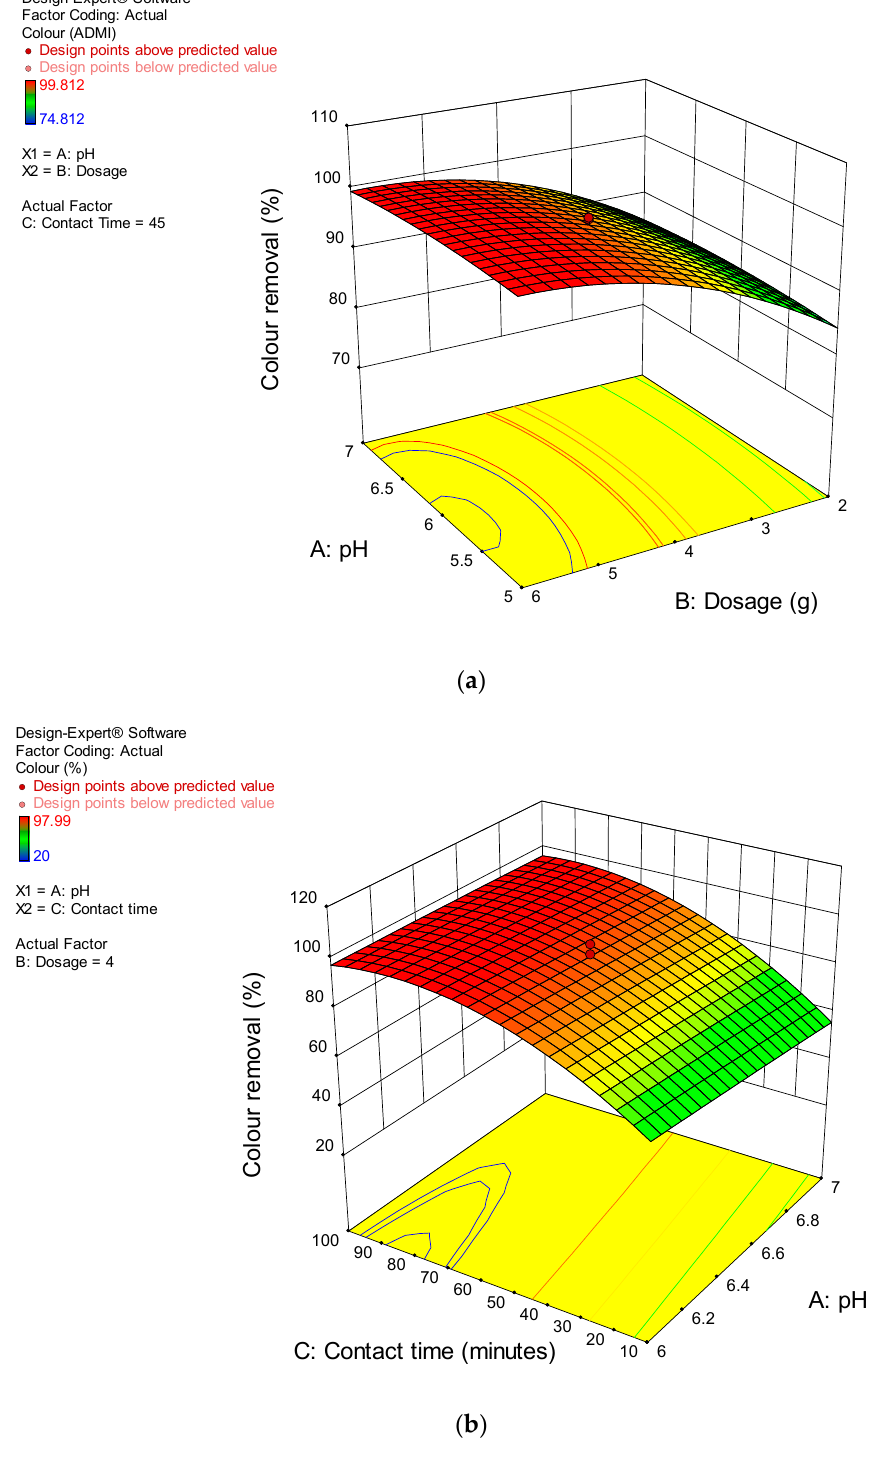
Figure 7. Colour removal from POME under variable: ( a ) dosage, B and pH, A; ( b ) contact time, C and pH, A.